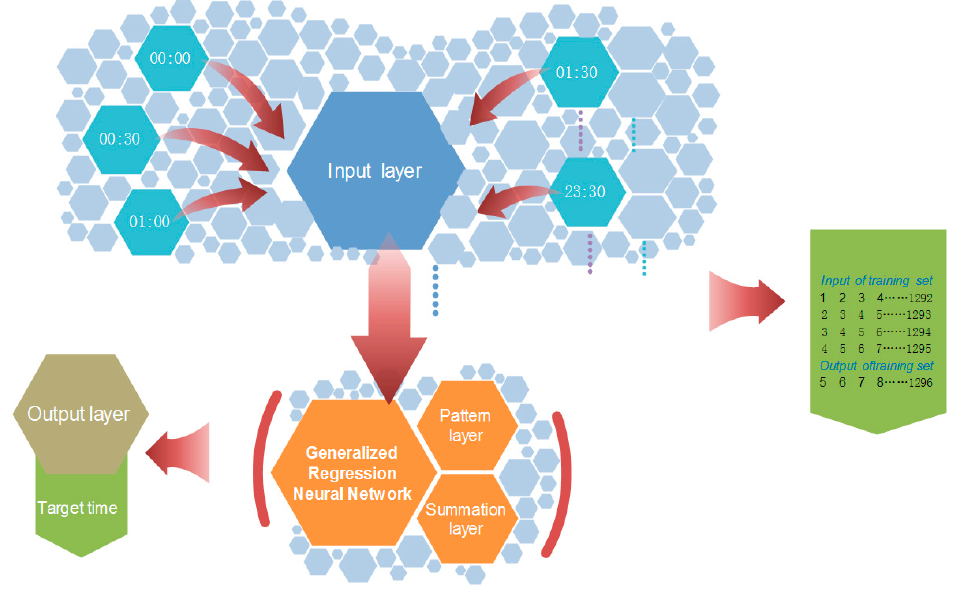
Figure 4. The generalized regression neural network model.